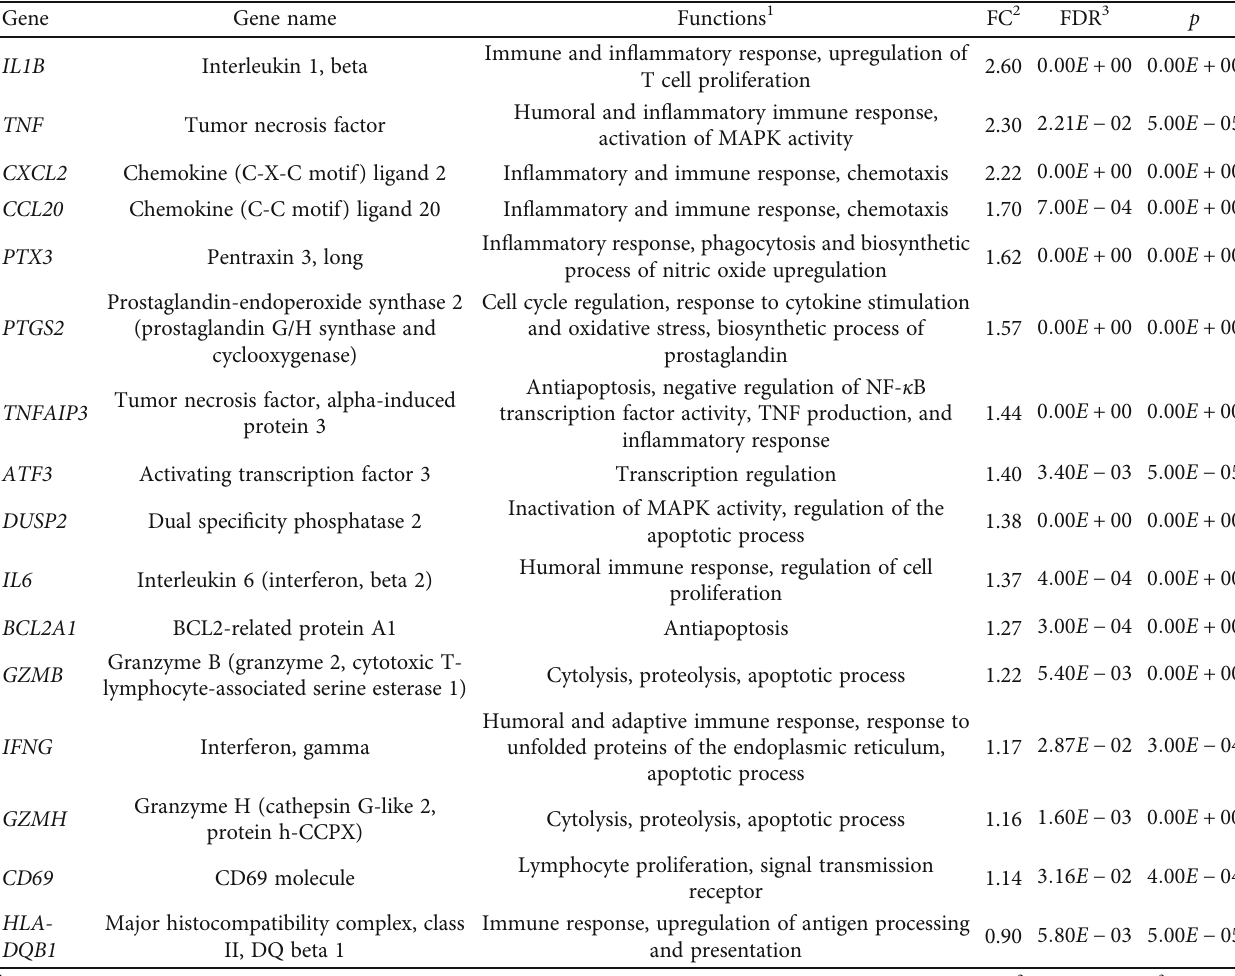
Table 3: List of di ff erentially expressed genes, which have been widely related to T1D in the literature, in peripheral blood mononuclear cells (PBMCs) of T1D patients compared to the control